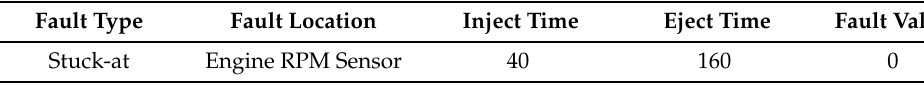
Table 7. Configuration of transient fault